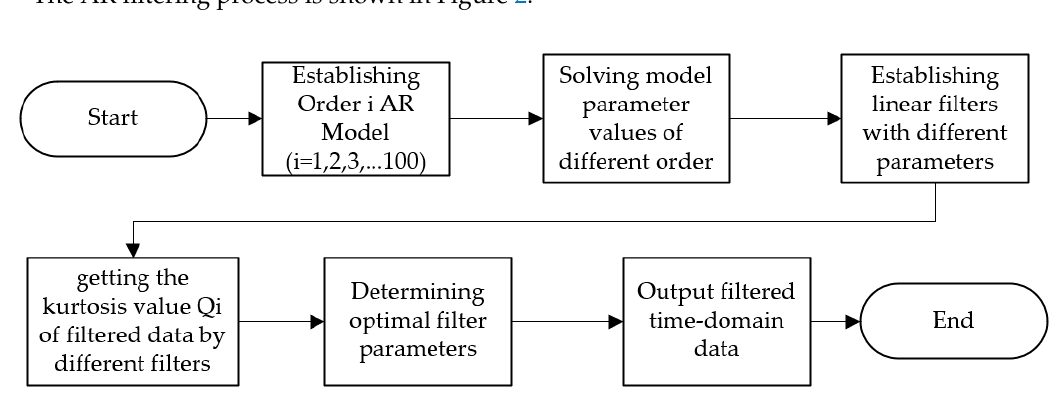
Figure 2. Autoregressive (AR) model filter filtering process.